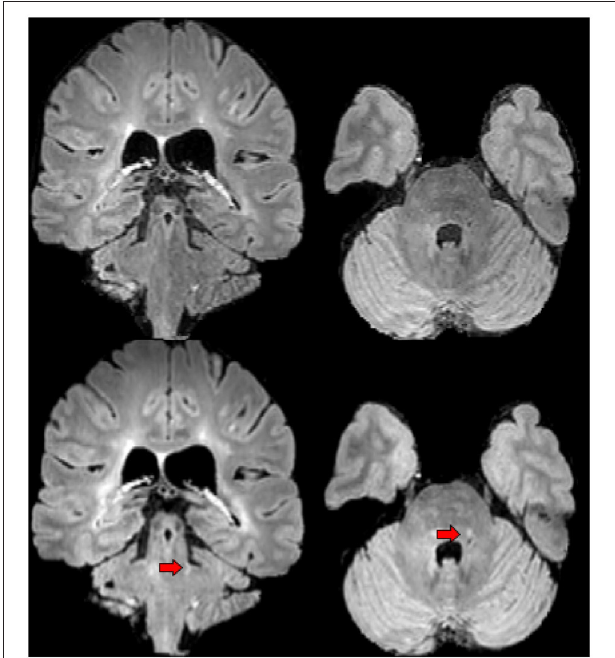
FIGURE 5 | An example of lesion detected by expert 1 in the first phase of the experiment but not by experts 2 and 3. First row shows the baseline FLAIR scan (from left-to-right: coronal and axial view), second row shows the FLAIR scan 1 year later (from left-to-right: coronal and axial view). Red arrows designate the lesion of